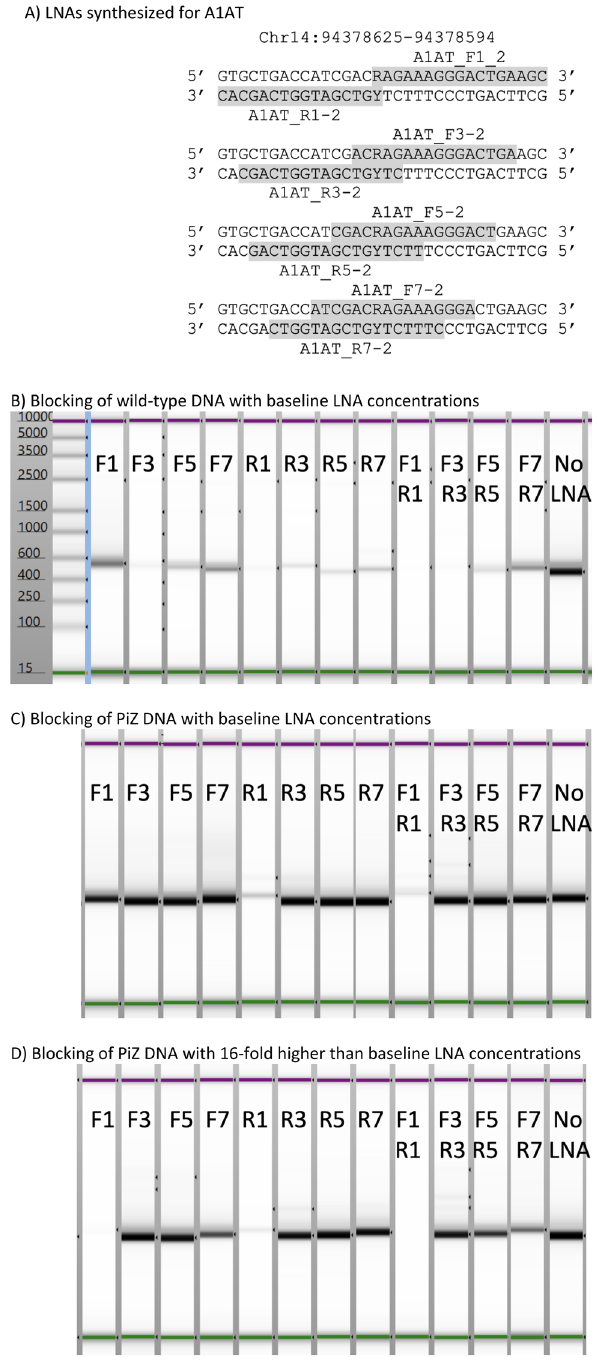
Figure 5. Blocking A1AT . ( A ) The sequence surrounding the PiZ allele in A1AT is shown (central base, R/Y). G/C is the wild-type sequence and A/T is the PiZ allele. LNAs are named with an F if identical to the top strand and R if identical to the bottom strand. The number adjacent to F/R indicates where the PiZ allele is in the LNA. Individual LNAs and how they overlap are shaded. Because each LNA varies by two in length, the alternating LNAs are positioned identically in these series. Based on potency in initial studies at 1 and 10 µM, concentrations were titrated to obtain good but not complete blocking at the lowest concentrations used. The lowest concentration for A1AT_R1-2 was 0.1 µM, followed by A1AT_F3-2, A1AT_R3-2, and A1AT_R5-2 at 0.2 µM, A1AT_F5-2 and A1AT_R7-2 at 0.5 µM, A1AT_F7-2 at 1 µM, and A1AT_F1-2 at 3.3 µM. ( B ) Blocking of wild-type DNA with LNA concentrations listed in ( A ). ( C ) Blocking of PiZ DNA with LNA concentrations listed in ( A ). ( D ) Blocking of PiZ DNA with LNA concentrations 16-fold higher than listed in ( A ). Data is not shown for the 16 × wild-type DNA because all LNAs completely blocked